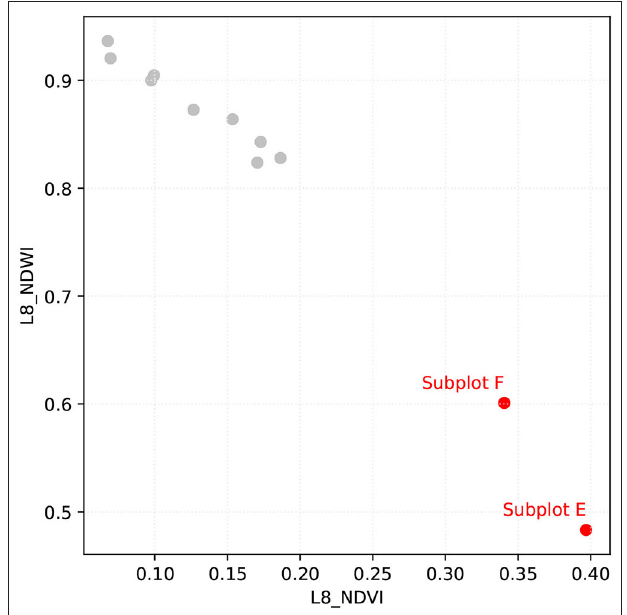
FIGURE 10 | Average Landsat’s NDVI and NDWI values for all LCZ 17 polygons, for Bamako. Suspicious polygons from subplots E and F in Figure 8 are shown in